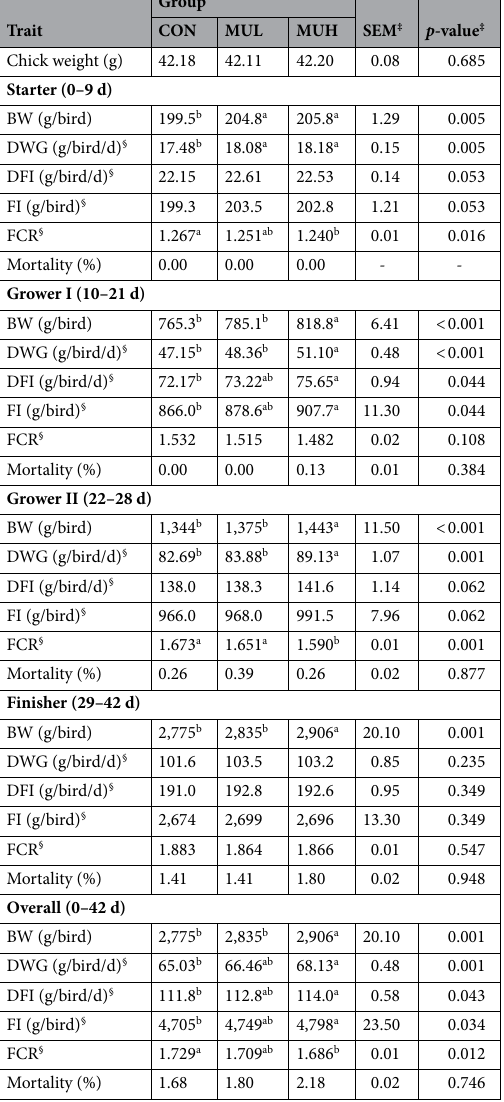
Table 1. Performance traits of CON, MUL, and MUH at the end of each feeding phase and in the overall trial (0–42 d) † . † Mean values of 12 replicates per group arranged in a randomized complete block design. ‡ Reported values refer to the experimental factor group. § Corrected for mortality. a, b Within a row, means with no common superscripts differ significantly ( p -value ≤ 0.05). SEM: Standard error of the